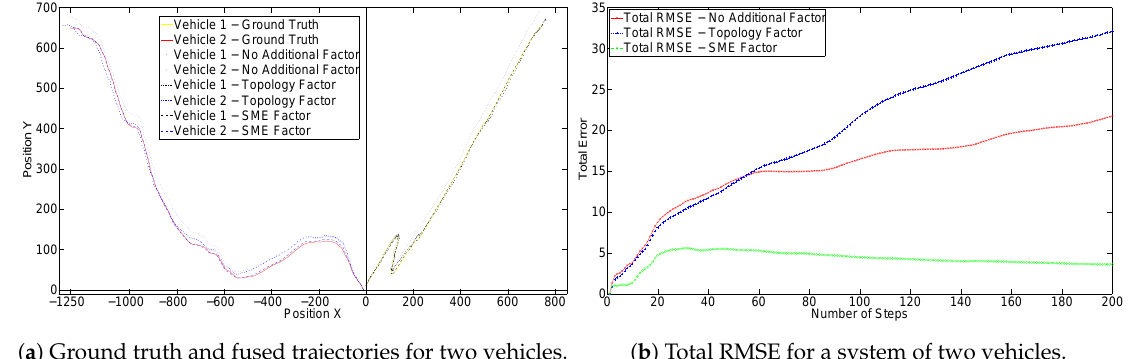
Figure 4. First set without GPS for two randomly simulated